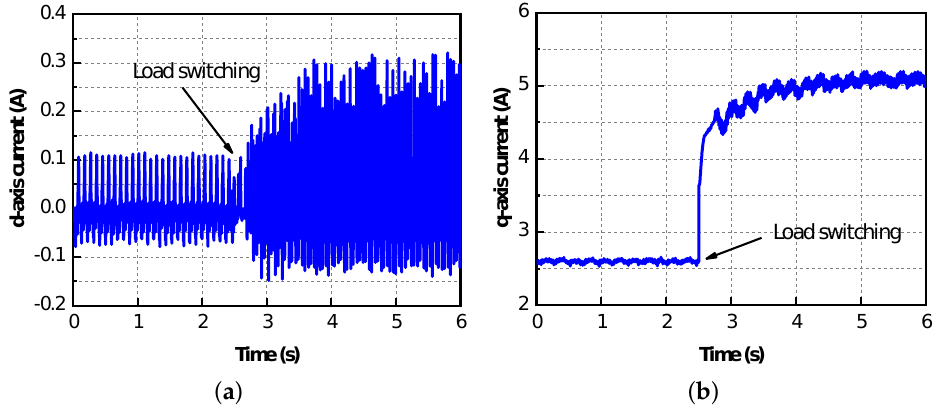
Figure 28. Experimental results.( a ) d-axis current and ( b ) q-axis current. Figure 29 shows the estimated value of the stator inductance. Since the q-axis cur- rent increases after the load is switched, the saturation degree of the iron core increases. Therefore, the inductance of the d-axis and q-axis